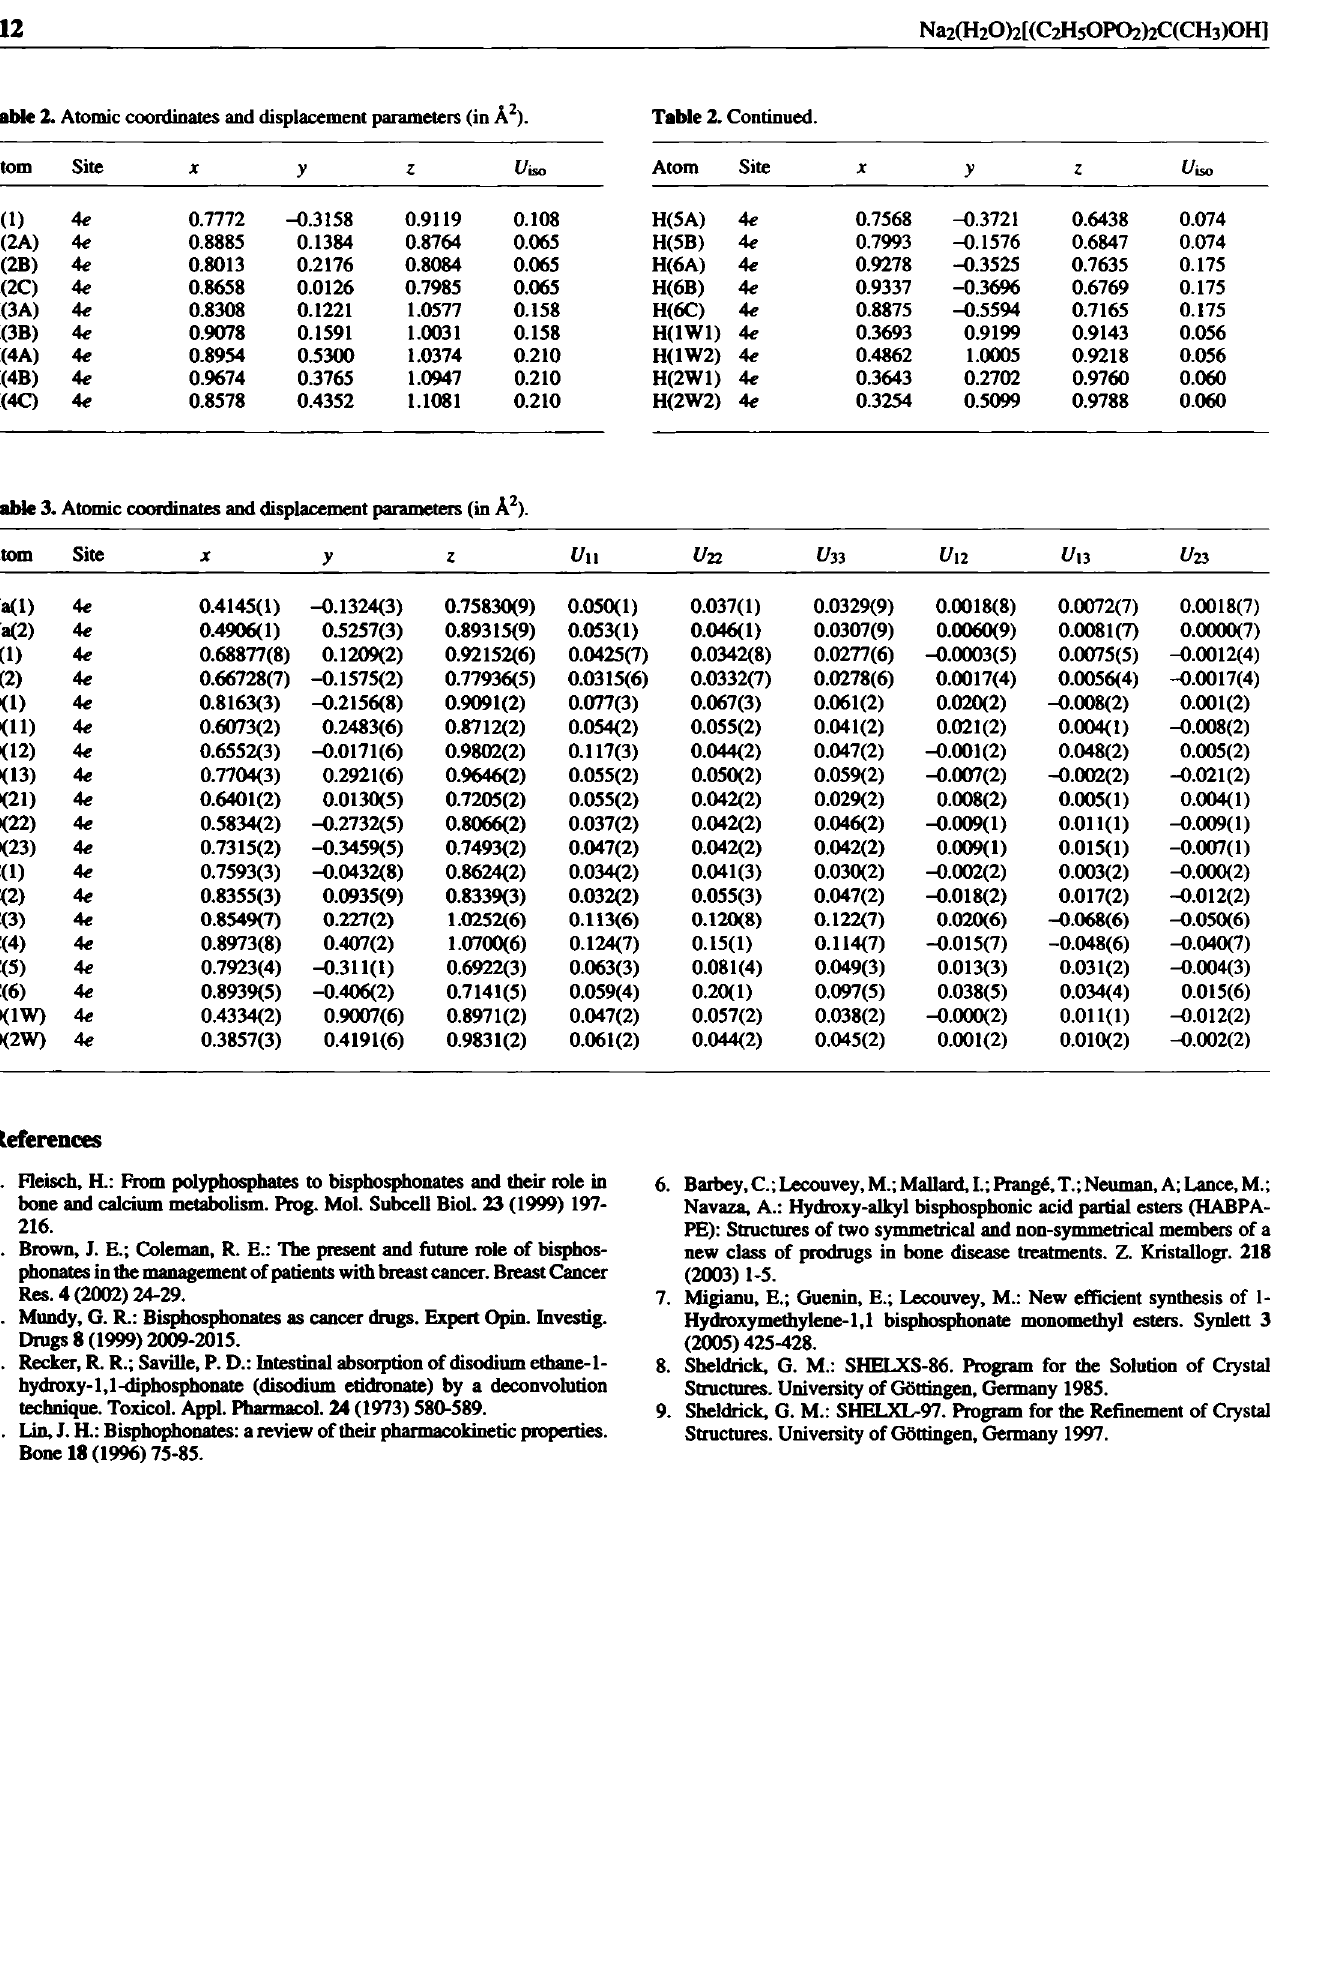
Tabic 2. Atomic coordinates and displacement parameters (in A 2 ).